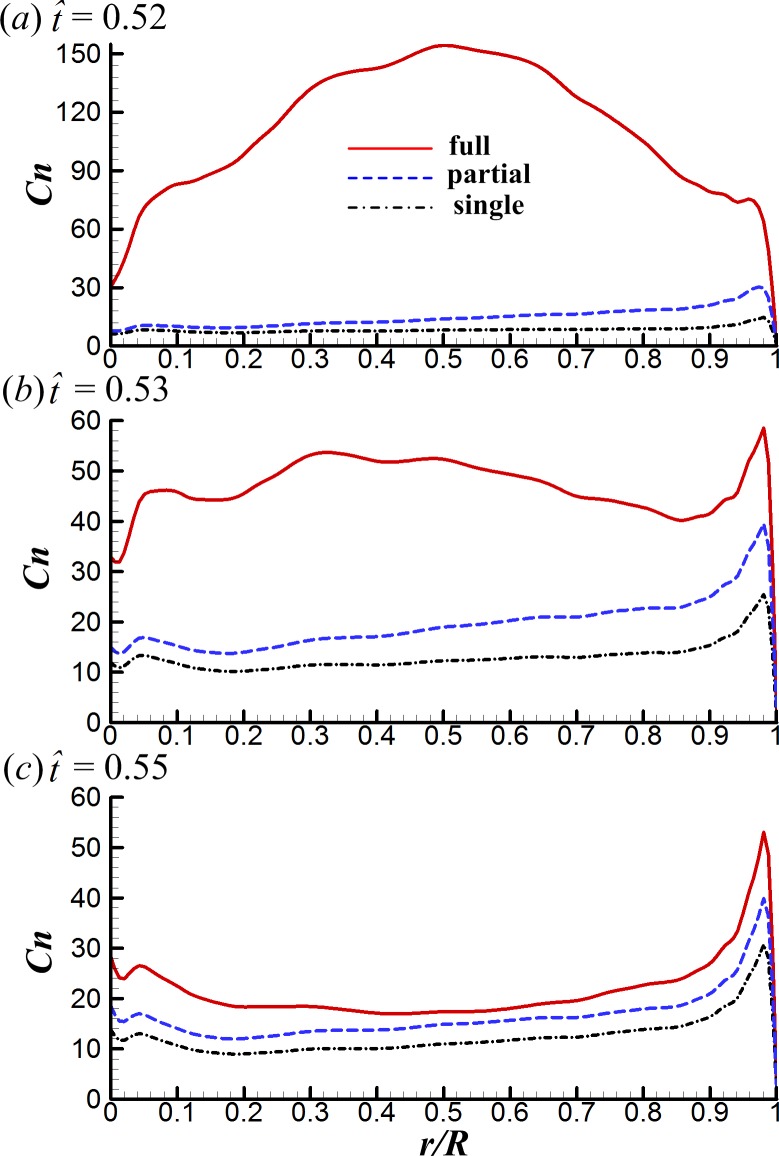
The spanwise distributions of the sectional normal force of the three cases considered at \documentclass[12pt]{minimal}
\usepackage{amsmath}
\usepackage{wasysym}
\usepackage{amsfonts}
\usepackage{amssymb}
\usepackage{amsbsy}
\usepackage{upgreek}
\usepackage{mathrsfs}
\setlength{\oddsidemargin}{-69pt}
\begin{document}
}{}$\hat {t}=0.52$\end{document}t ˆ=0.52, 0.53 and 0.55.